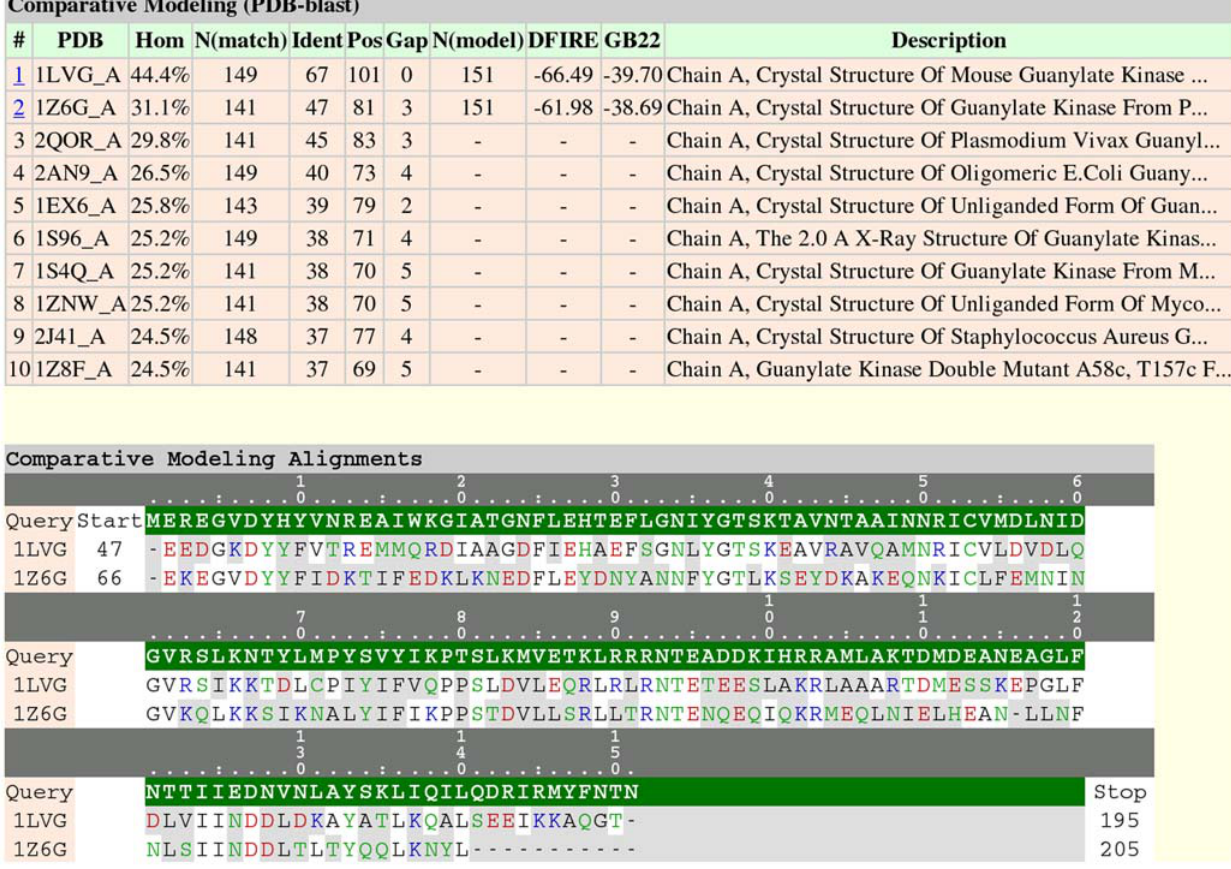
Figure 2. Screenshot of the pipeline-rendered comparative modeling results in hypertext markup language (HTML) format for variola protein NP_042212.1. Color-coding for the amino acid letters is as follows: red, acidic; blue, basic; green, polar; and black,